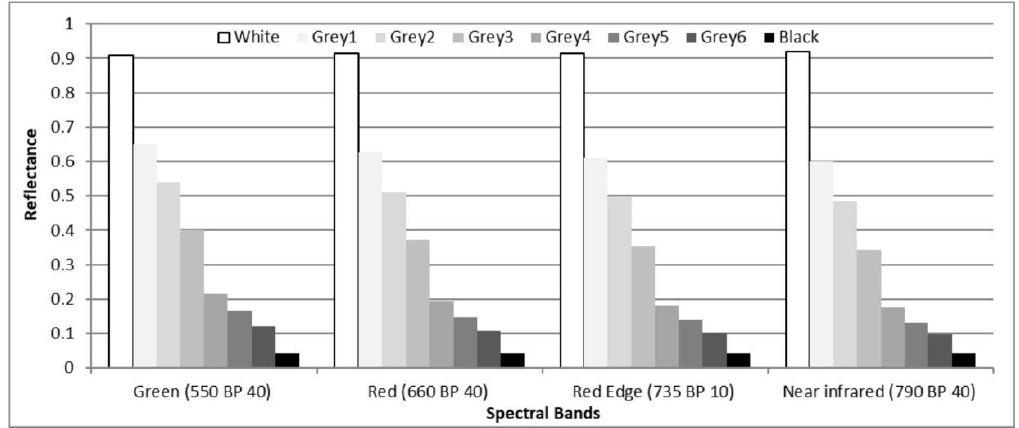
Figure 2. Measured spectral reflectance of the eight greyscale radiometric calibration panels, corresponding with the four Parrot Sequoia ® multi-spectral bands using a handheld ASD visible- near-infrared (NIR) range